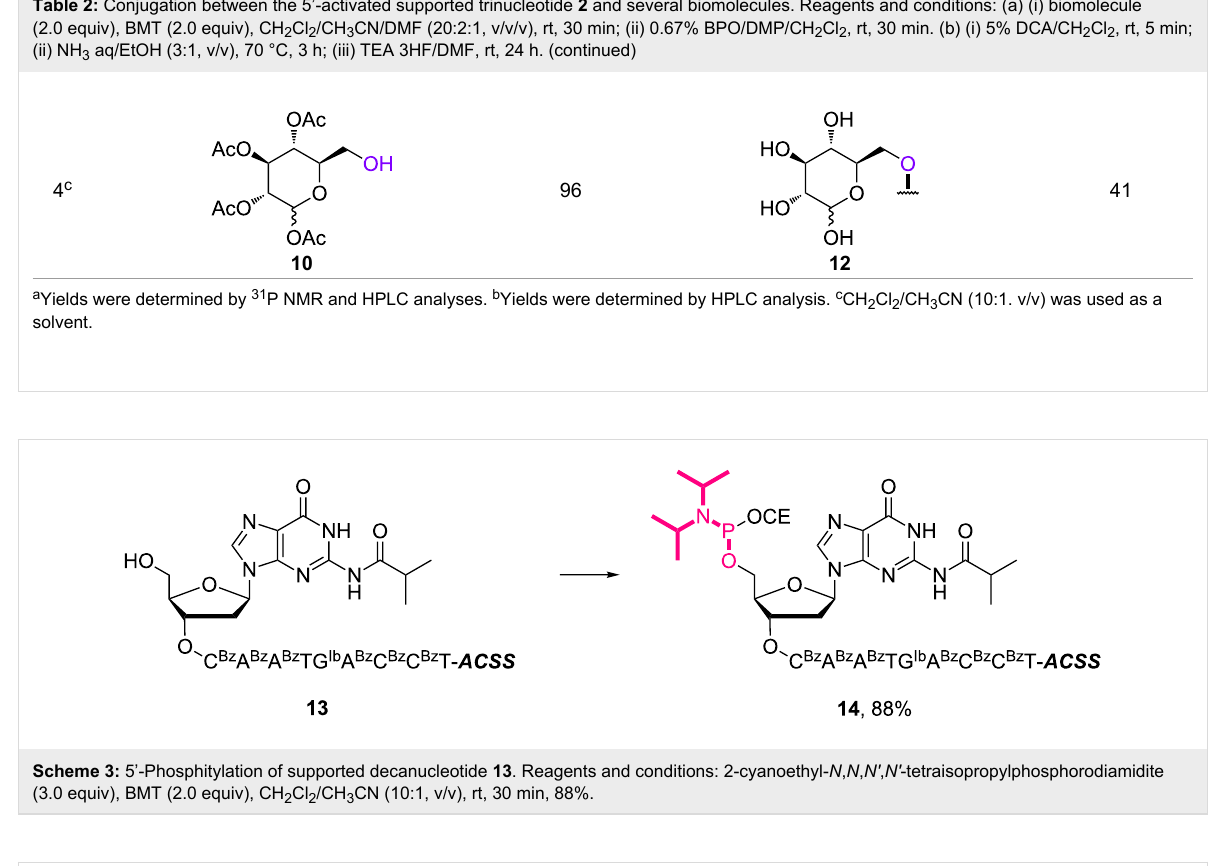
Table 2: Conjugation between the 5’-activated supported trinucleotide 2 and several biomolecules. Reagents and conditions: (a) (i) biomolecule (2.0 equiv), BMT (2.0 equiv), CH 2 Cl 2 /CH 3 CN/DMF (20:2:1, v/v/v), rt, 30 min; (ii) 0.67% BPO/DMP/CH 2 Cl 2 , rt, 30 min. (b) (i) 5% DCA/CH 2 Cl 2 , rt, 5 min; (ii) NH 3 aq/EtOH (3:1, v/v), 70 °C, 3 h; (iii) TEA 3HF/DMF, rt, 24 h. (continued)